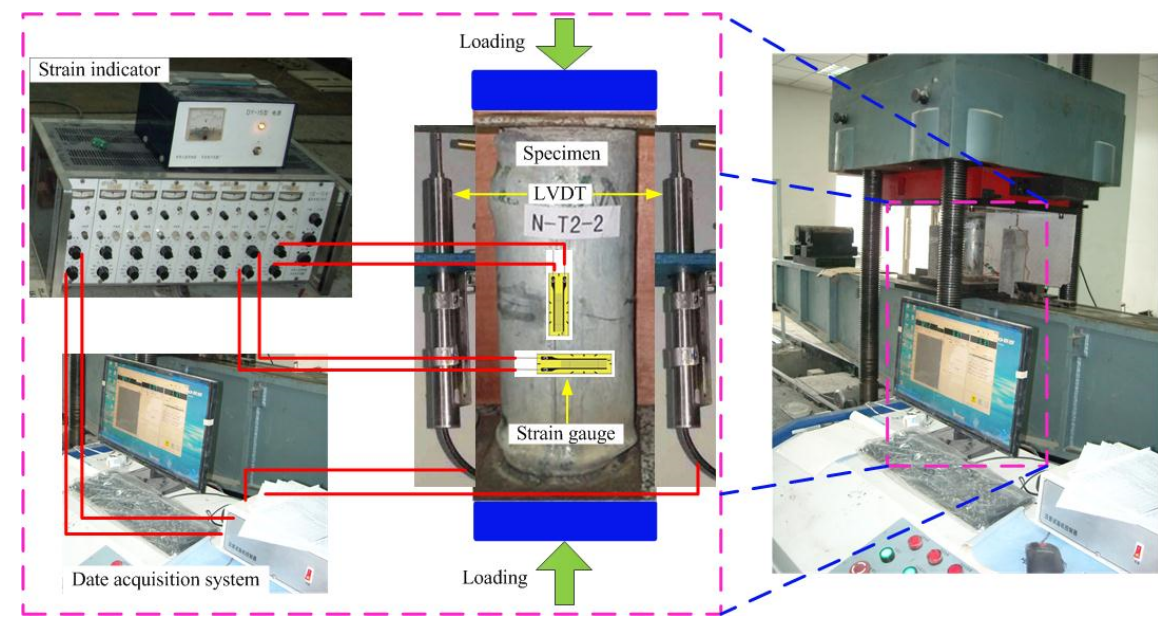
Figure 1. Photographs of loading arrangements.